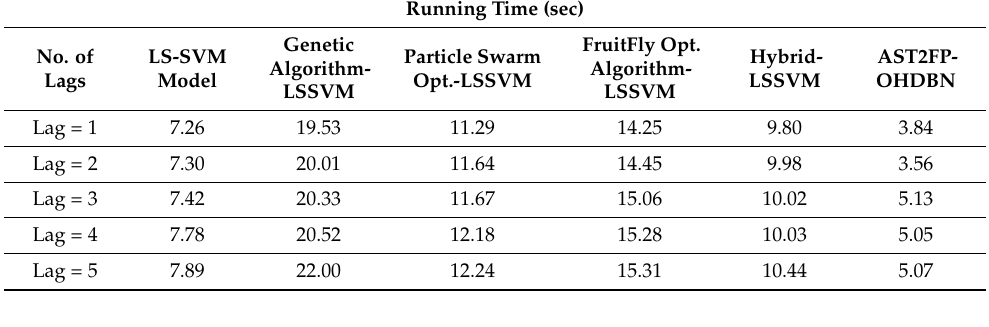
Table 4. RT analysis of AST2FP-OHDBN approach with existing methodologies.